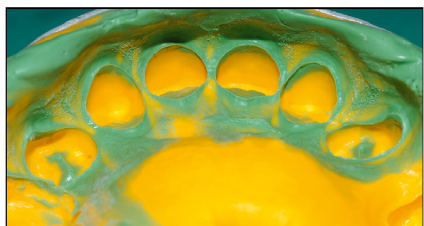
Figure 9: Impression of preparations made with addition silicone (Express-3M ESPE).